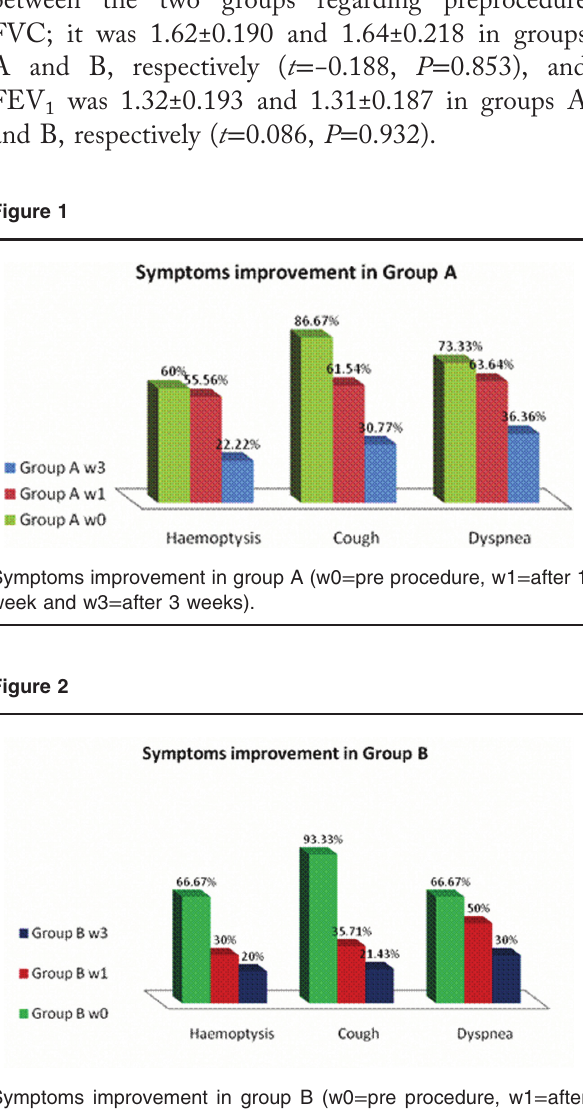
Symptoms improvement in group B (w0 = pre procedure, w1 = after 1 week and w3 = after 3